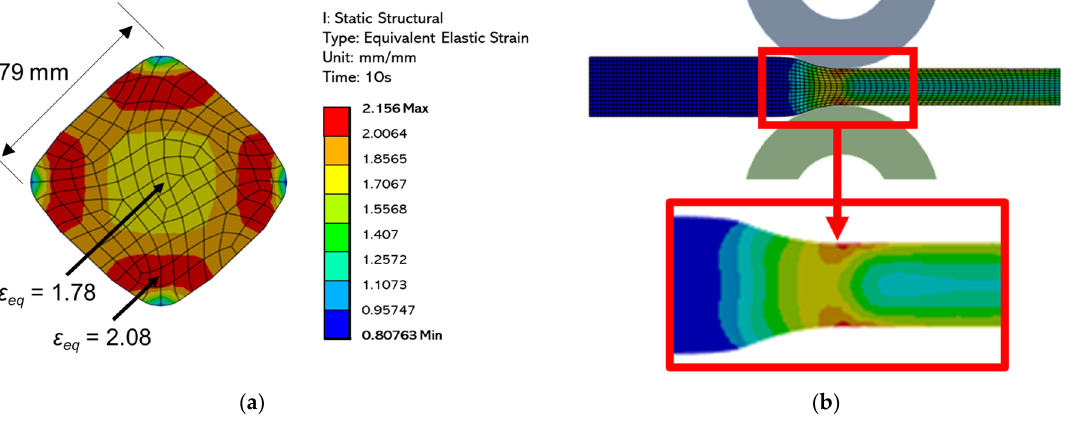
Figure 3. FEA contour maps of ε eq for AZ31 Mg alloy subjected to the eight-pass MPCR deformation: ( a ) on the cross-section and ( b ) on the lateral view.